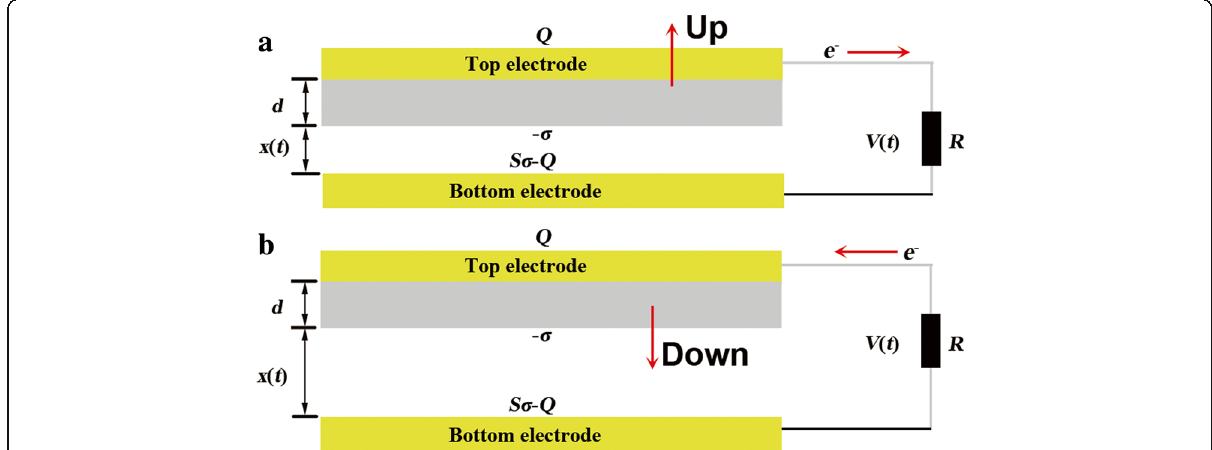
Fig. 1 The theoretical model for contact-mode of TENGAs. a Separation process and b contact